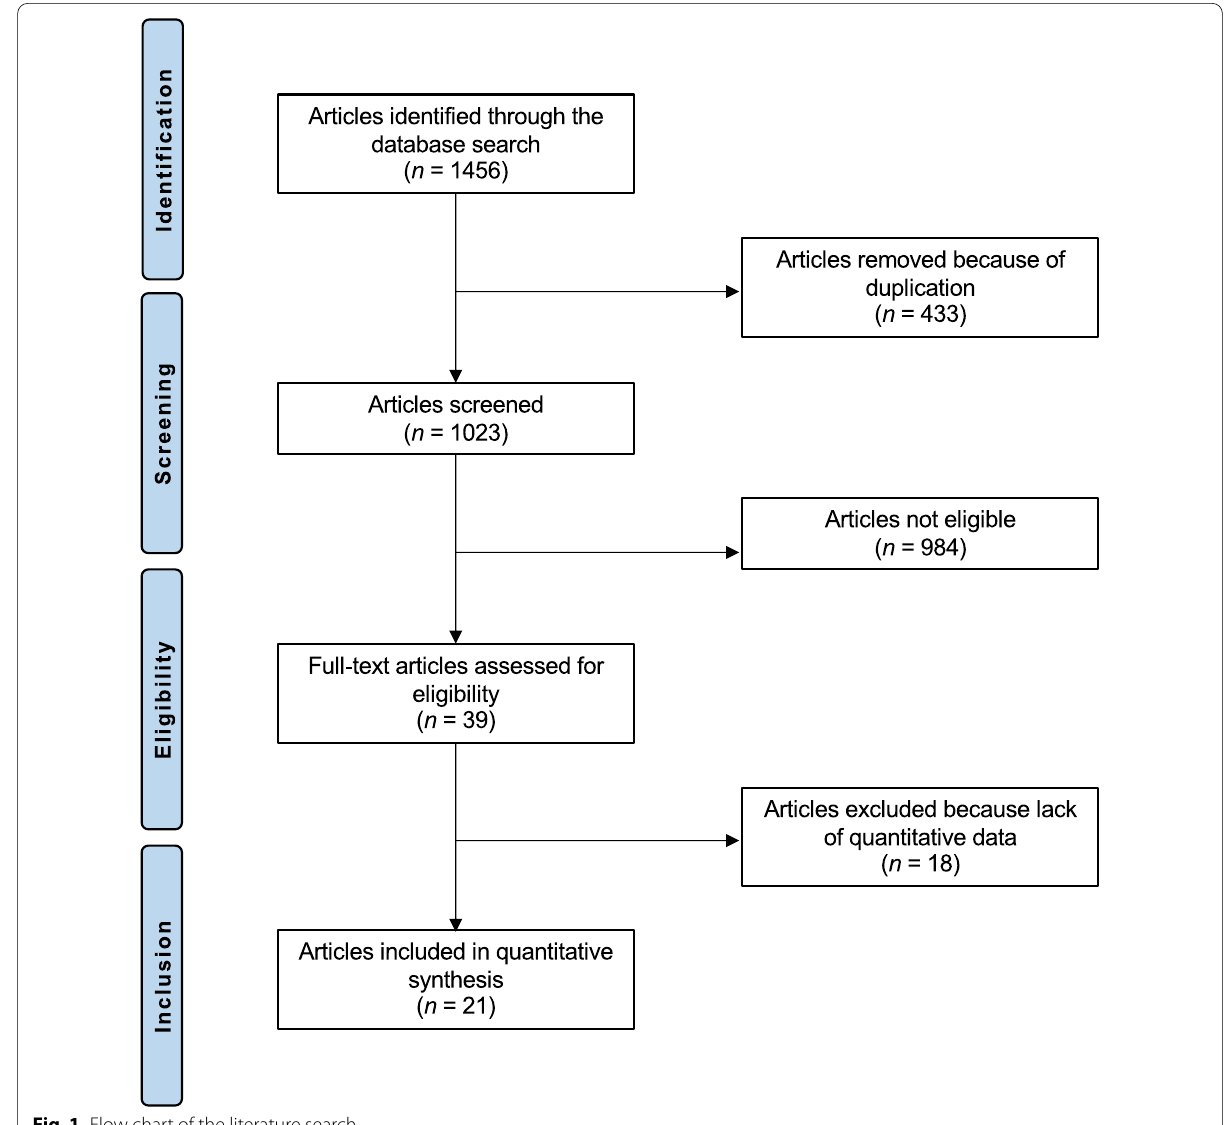
Fig. 1 Flow chart of the literature